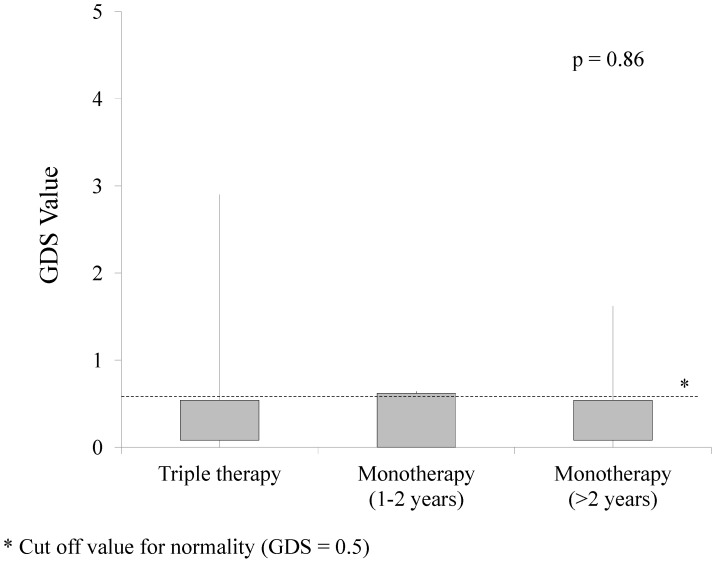
Distribution of neurocognitive performance by global deficit score (GDS).